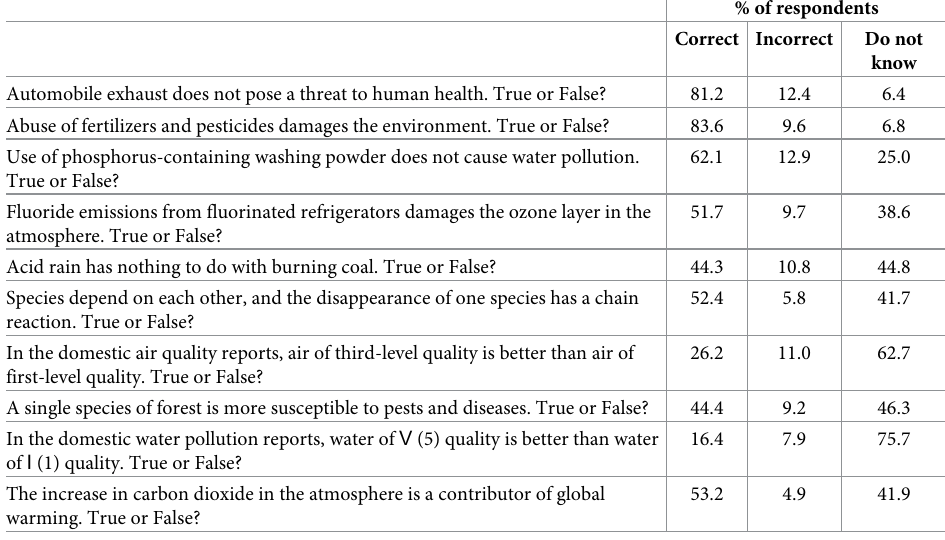
Table 7. Summary of environmental knowledge.